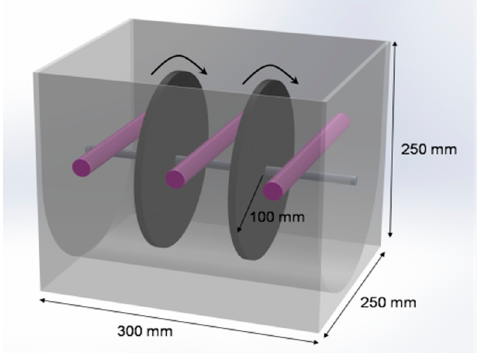
Figure 12. Configuration of the PRD-reactor.